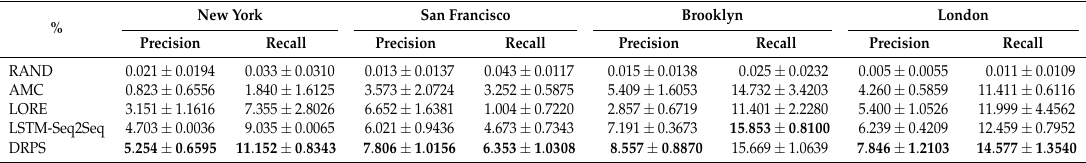
Table 4. Performance comparison on four cities in terms of precision and recall under the setting where the input and output lengths are, respectively, 30 and 5. The numbers in bold face indicate the ones with the best performances.